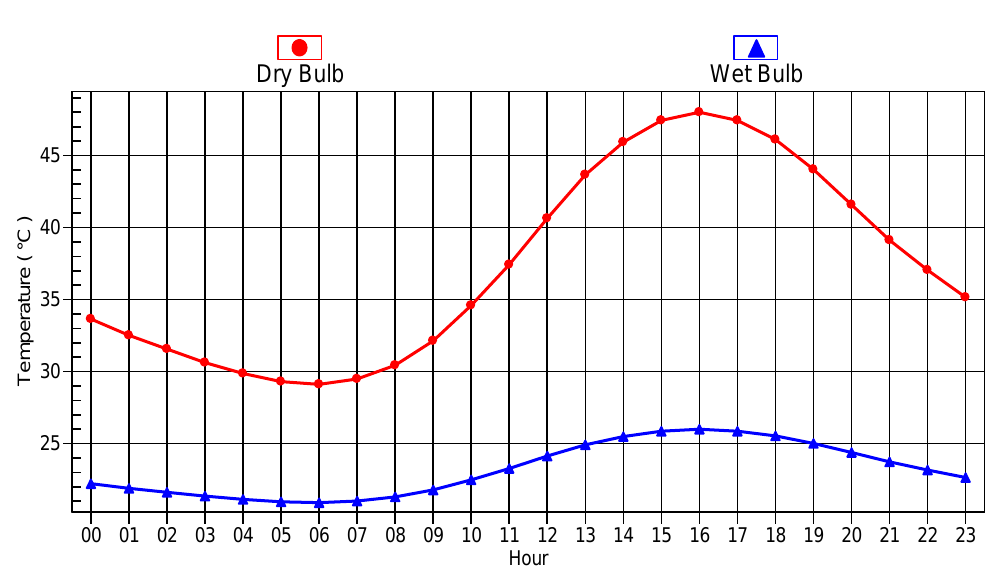
Figure 3. Design temperature profiles for